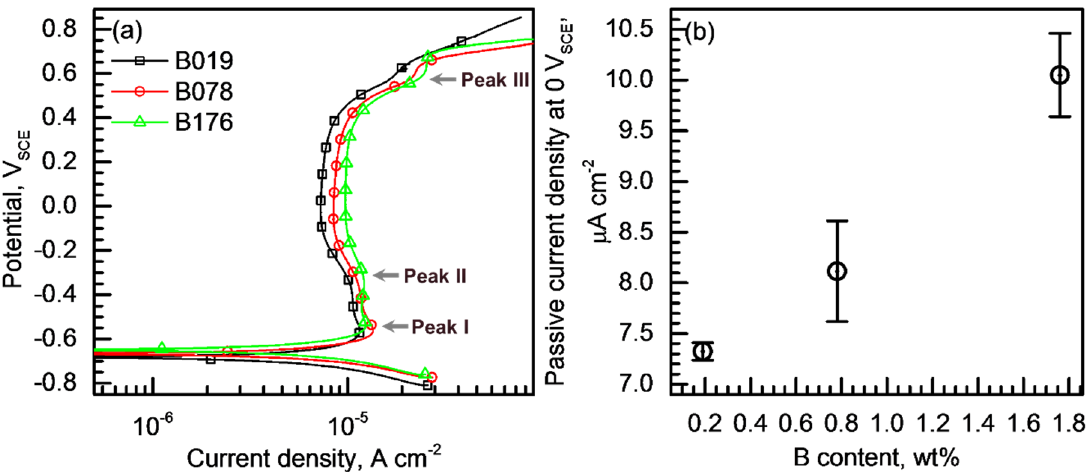
Figure 8. ( a ) Potentiodynamic polarization curves of the alloys measured in a borate–phosphate–citric buffer solution with pH 8.5 (0.2 M boric acid + 0.05 M citric acid + 0.1 M tertiary sodium phosphate) at 20 ± 1 °C at a potential sweep rate of 2 mV s − 1 ; ( b ) Variation of the average passive current density values of the alloys as a function of the B content.